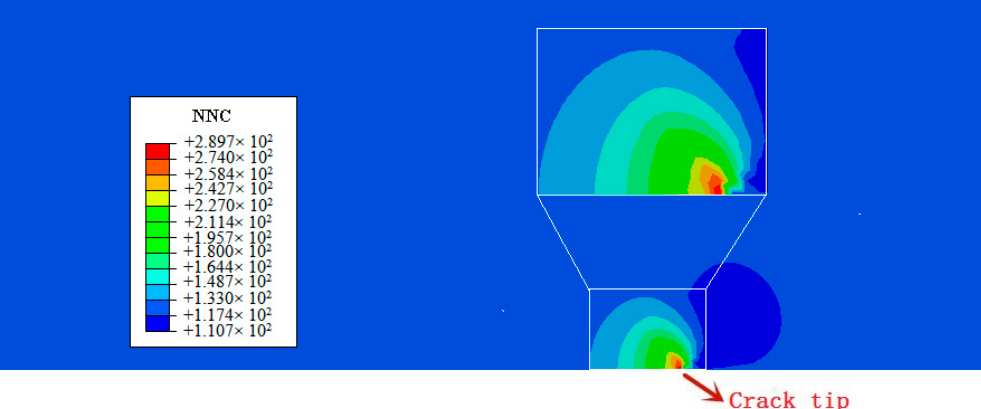
Figure 13. The contour plots of normalized hydrogen concentration after 600 s diffusion. NNC: normalized hydrogen concentration.